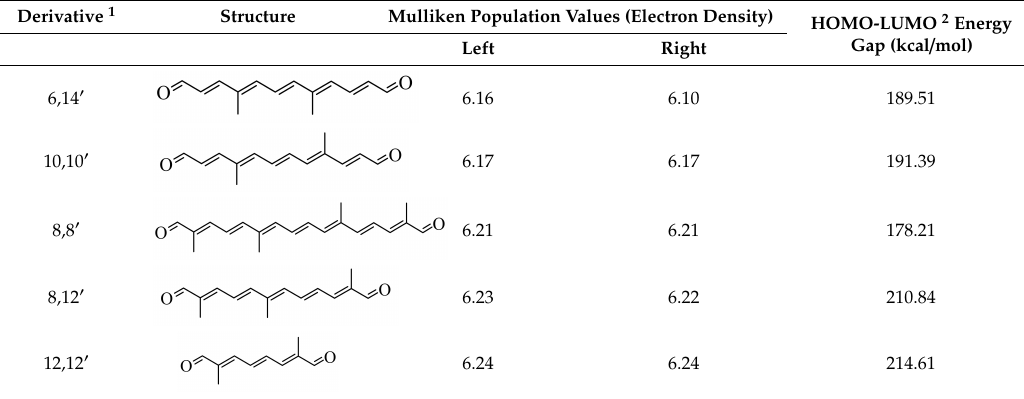
Table 1. Structures, Mulliken population values, and HOMO-LUMO energy gap of the synthetic